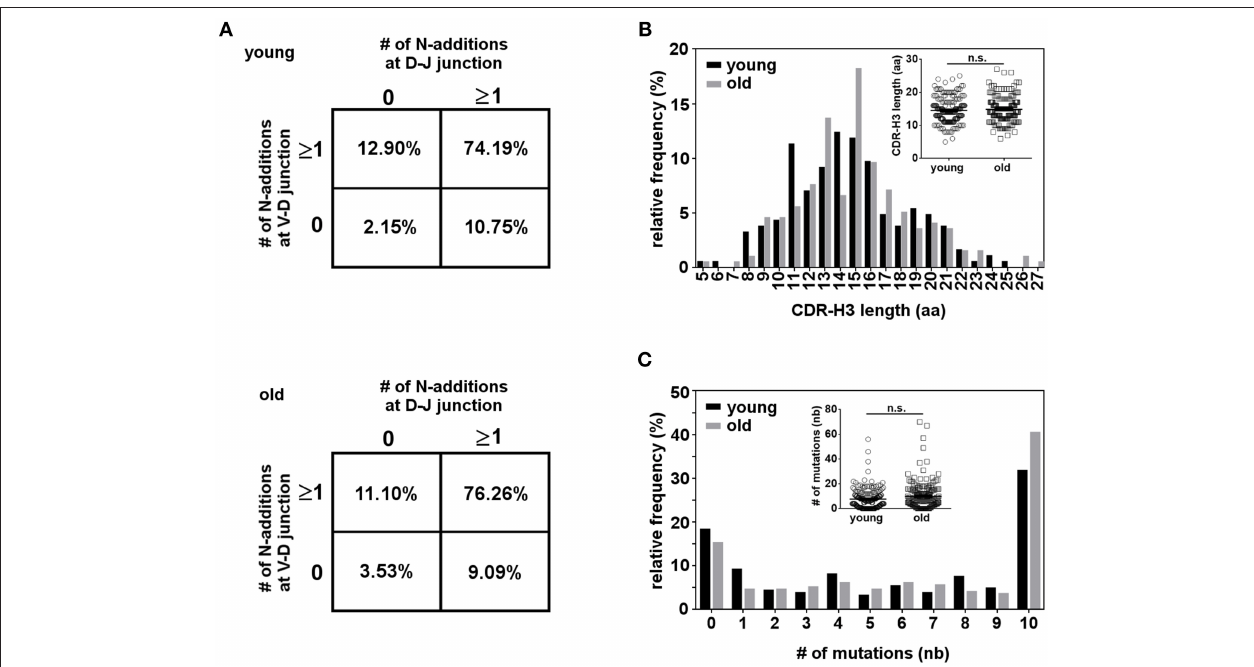
FIGURE 7 | Characterization of the CDR-H3 region in the B-1 cell IGHM repertoire. B-1 cells from 10 young and 10 old donors were single cell sorted and the IgM VH regions were amplified and sequenced. From each clonotype only one representative sequence was considered for analysis. (A) N-region addition analysis of B-1 cell IgM from young and old donors. The percentages of sequences with zero N-additions at both junctions, one or more N-additions at both junctions, zero N-additions at V-D and one or more at D-J junctions, or zero N-additions at D-J and one or more at V-D junctions are shown. (B) Length distribution of complementarity determining region 3 (CDR-H3) is shown for B-1 cell IgM antibodies from young and old donors. Inset shows the distribution of individual CDR-H3 length from young and old donors (C) The distribution of somatic mutations for B-1 cell IgM antibodies from young and old donors is shown as percent of sequences with zero or more than one nucleotide mutation. Inset shows the distribution of mutations for each sequence from young and old donors. n.s. p > 0.05 by Mann–Whitney U